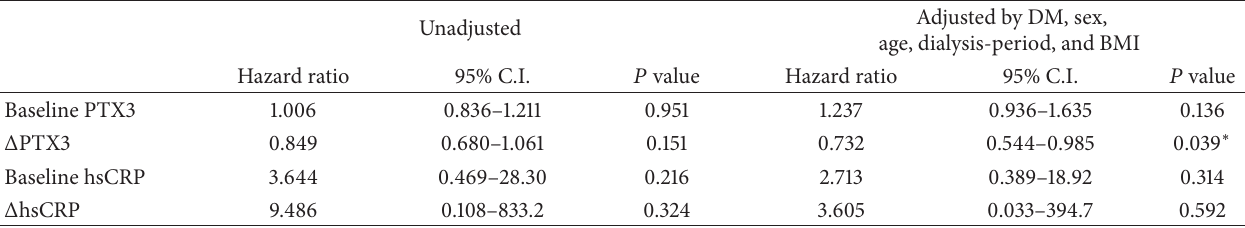
Table 3: Cox-regression models for the incidence of vascular access troubles with or without multivariable adjustment.